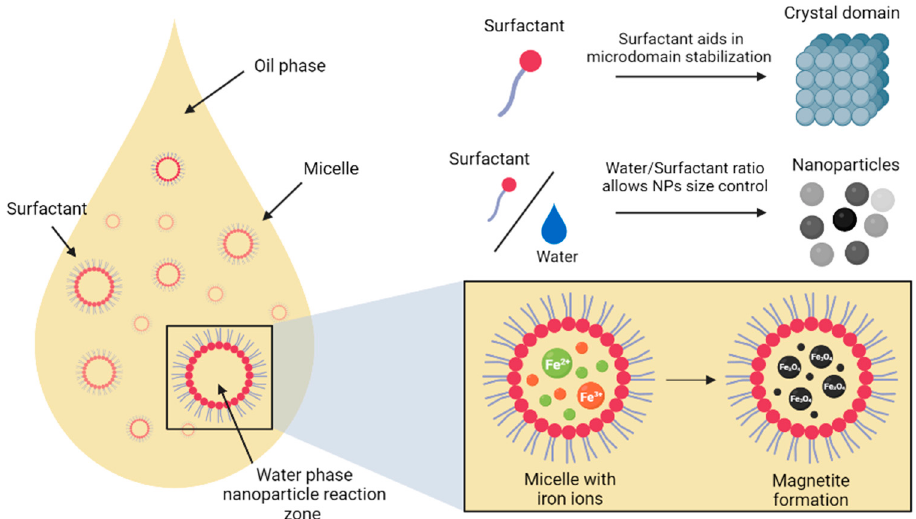
Figure 4. Representative micro ‐ domains of the two immersible phases in microemulsions.